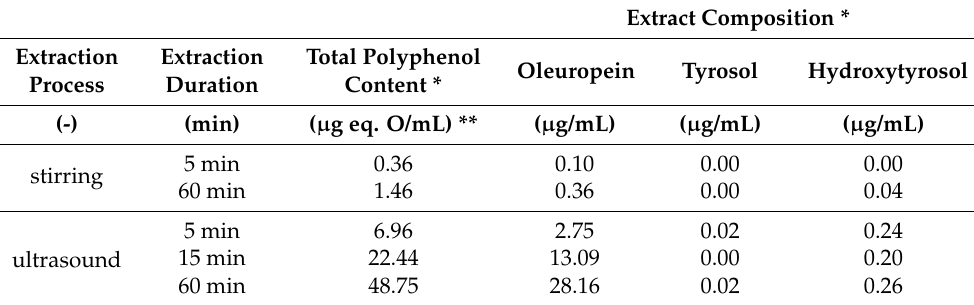
Table 1. Comparison of extraction performances (yield and polyphenol composition of extracts) for stirring and